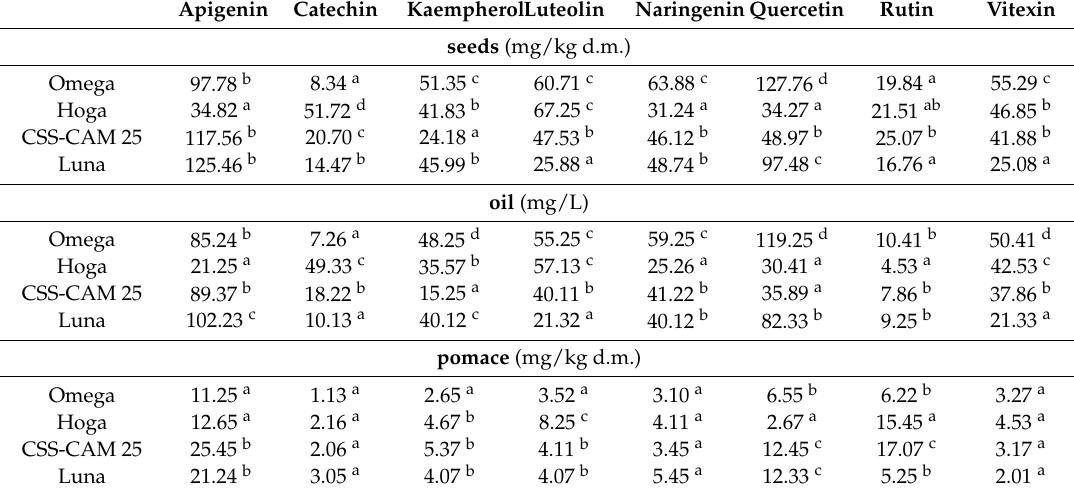
Table 1. The mean content of flavonoids in spring and winter genotypes of Camelina sativa. Apigenin Catechin KaempherolLuteolin Naringenin